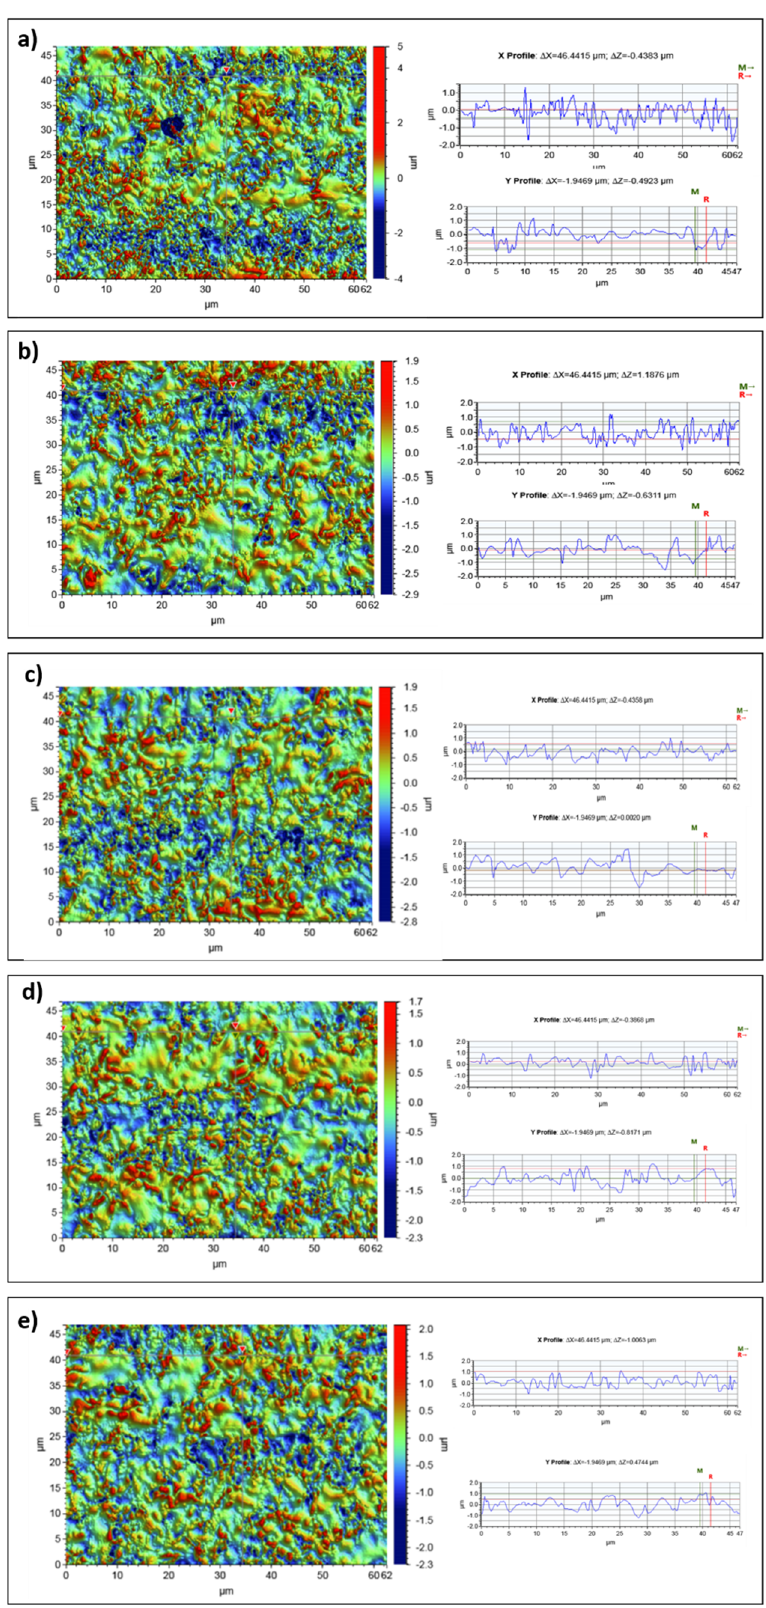
Figure 3. The surface microgeometry maps made for dental implants ( a ) randomly selected site, ( b ) control, ( c – e ) irradiation variants, and the height profiles made in the X axis (upper profile) and Y axis (lower profile) for a scan size of 117 µm × 156 µm.